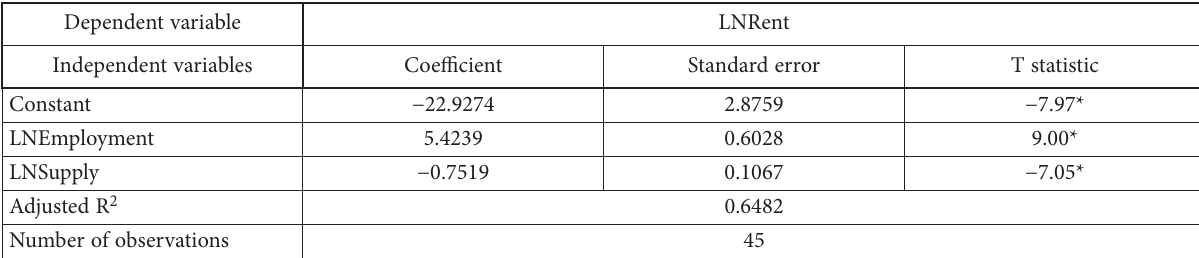
Table 3. The long-term equation in the symmetric model (source: own